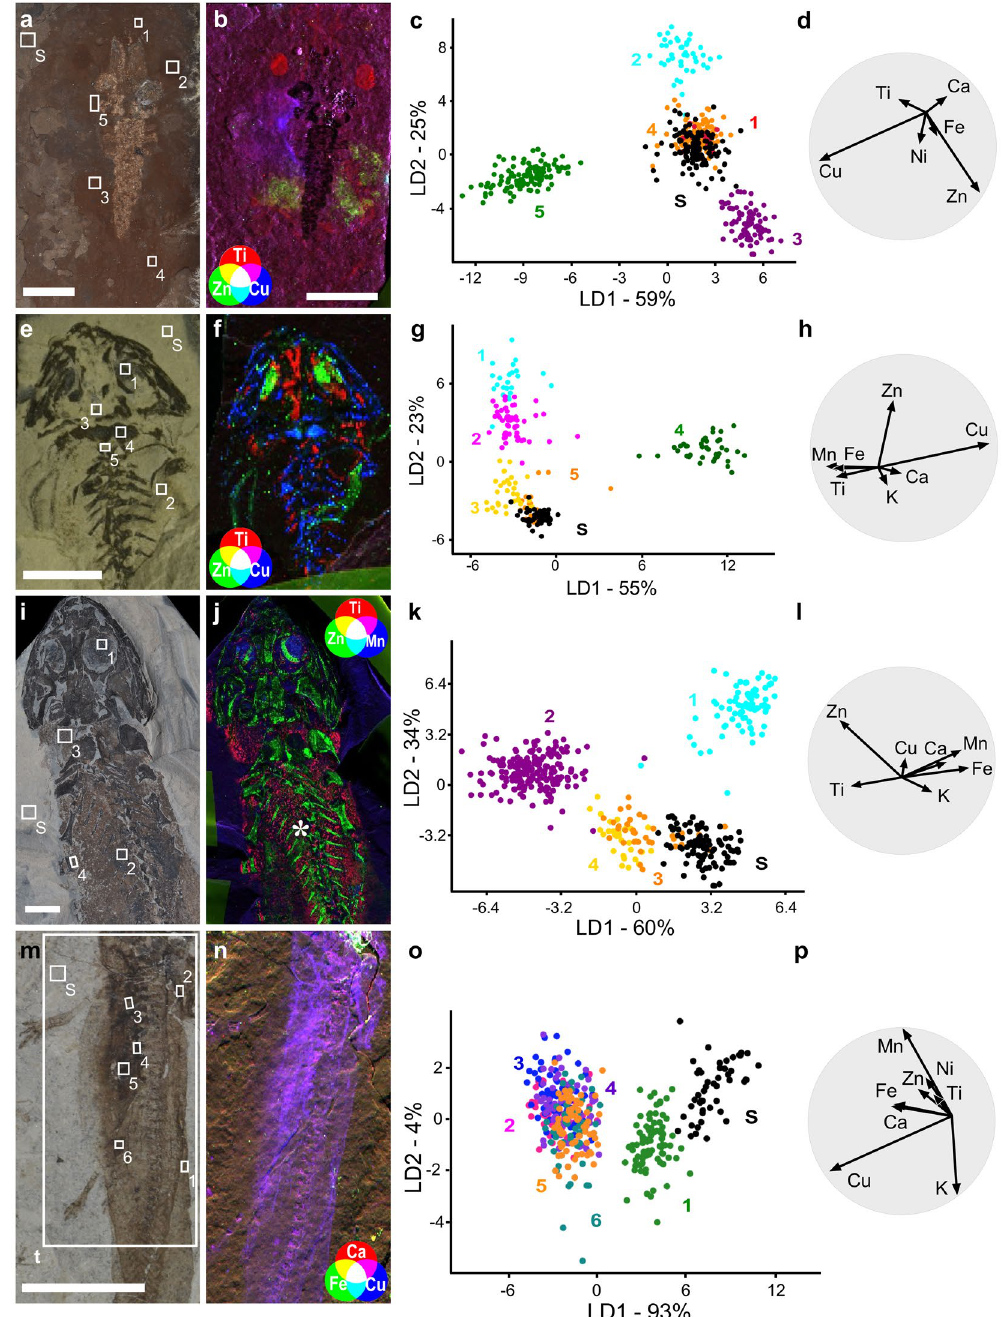
Figure 3. SRS - XRF and LDA analysis of individual fossil specimens. ( a–d ) P. diluvianus (NHML-30271); ( e–h ) B. amplystomus (NHMD-155208); ( i–l ) M. credneri (NHMB-MB-Am.-1187). ( m–p ); Amphibia indet. (CNU- SAL-NN2013002P); ( b,f,j,n ) SRS-XRF tricolor maps of each specimen; maps created using SMAK 1.50 https:// www.sams-xrays.com/smak. Asterisks ( * ) denote internal tissues. ( c,g,k,o ) LDA plot for each specimen; colours and numbers denote different regions of interest; S, sediment. ( d,h,l,p ) biplots showing the most discriminating variables, i.e. those that contribute most to the separation among